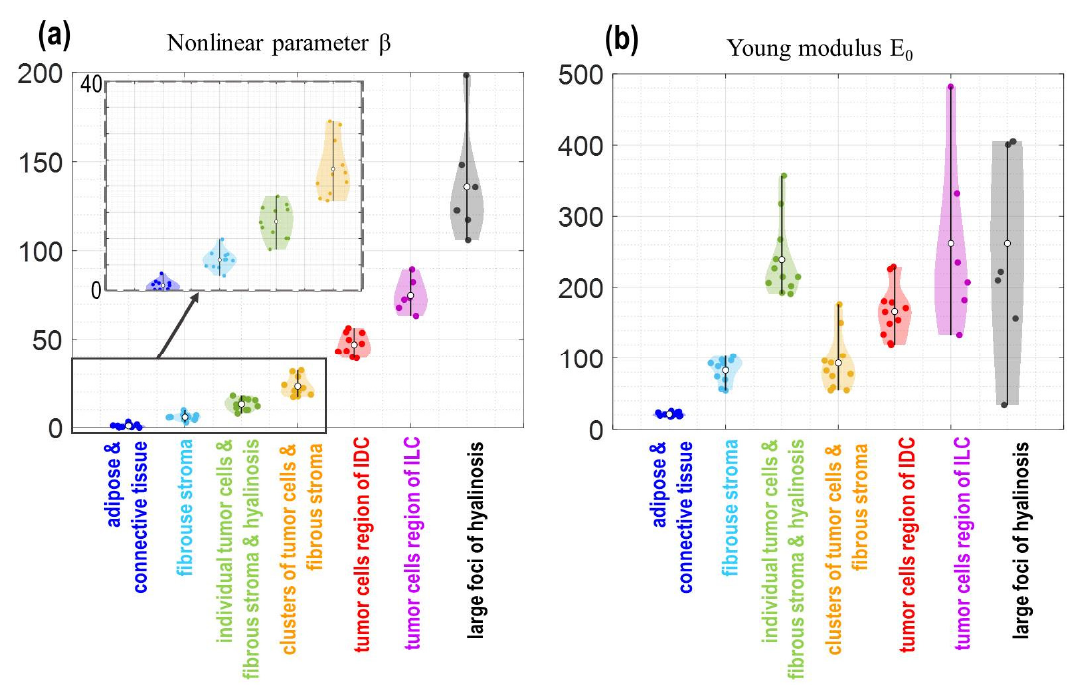
Figure 6. Nonlinear parameter β ( a ) and Young’s modulus E 0 ( b ) for different types of breast tissues: blue dots—nontumor breast tissue (adipose tissue with layers of connective tissue); light-blue dots—benign fibroadenomatosis or fibroadenoma; green dots—area of IDC, which is characterized by individual tumor cells and dense fibrous stroma with hyalinosis of collagen fibers (scirrhous structure); orange dots—area of IDC, consisting of separate large clusters or nests of tumor cells distributed in the fibrous stroma (solid-scirrhous structure); red dots—area of IDC which is characterized by solid growth with a small amount of stroma; magenta dots—area of ILC, which is characterized by solid growth; black dots—large foci of hyalinosis. The inset in ( a ) shows the data for the first four tissue types in more detail. (Abbreviations: IDC—invasive ductal carcinoma; ILC—invasive lobular carcinoma).